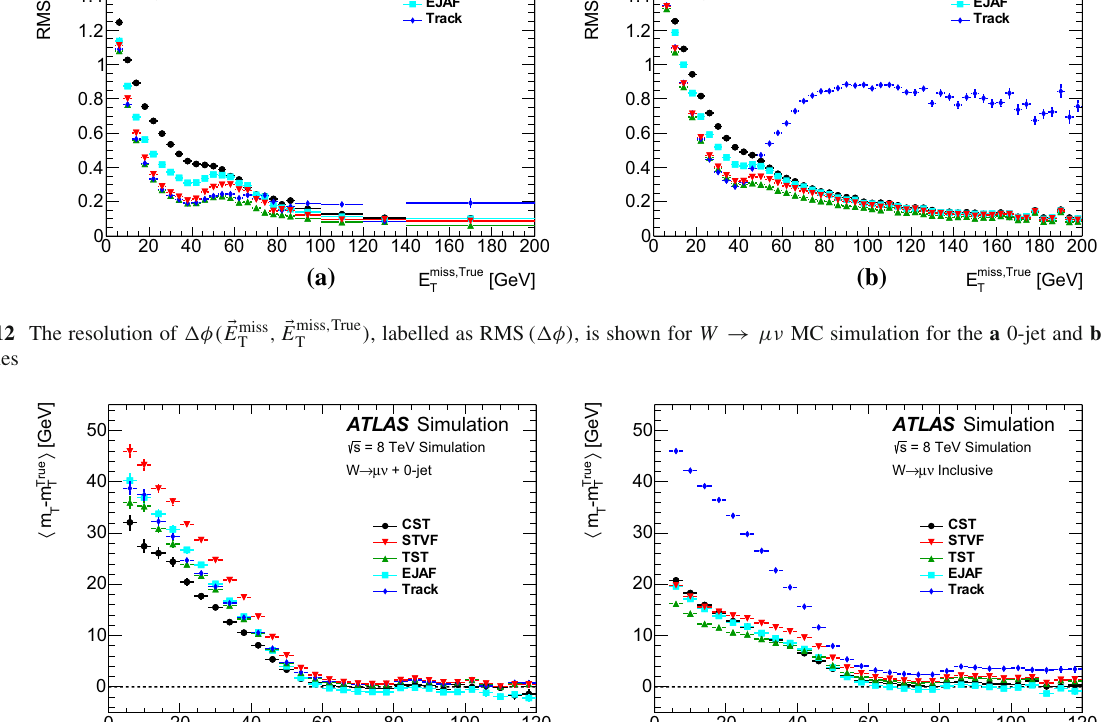
(cid:5) is shown versus m True Fig. 13 The (cid:4) m T − m True for W → μν MC simulation in the a 0-jet and b inclusive samples T T